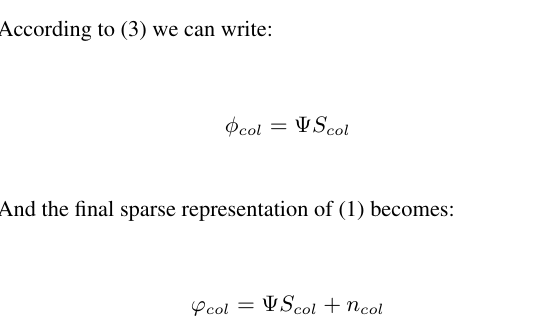
Figure 1: Flowchart of the proposed approach for SAR interferometric denoising via sparse